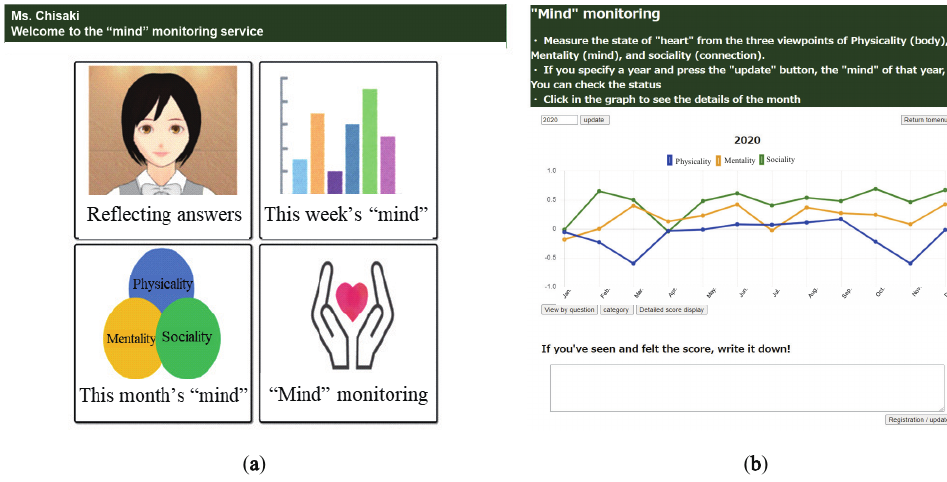
Figure 5. Screenshots of the implemented web application: ( a ) Data Visualizer. ( b ) Mind